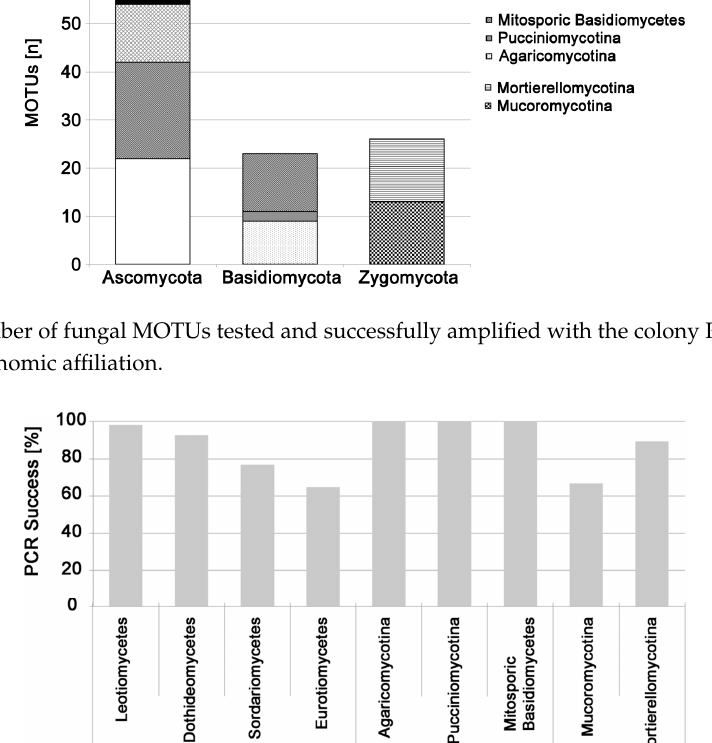
Figure 2. Direct PCR success for pure cultures of soil fungi belonging to different fungal subphyla.